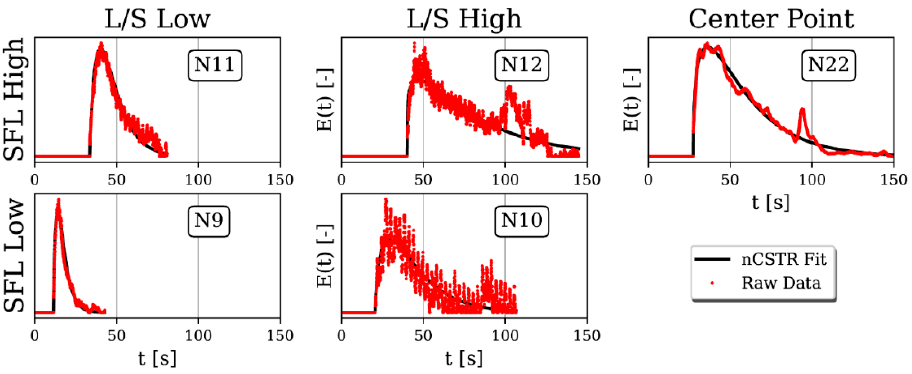
Figure 6. Volumetric probability density distributions (q 3 ) of continuous color saturation camera measurements (red dots) approximated by a nCSTR fit (black line) for varying SFL and L/S on a long screw.